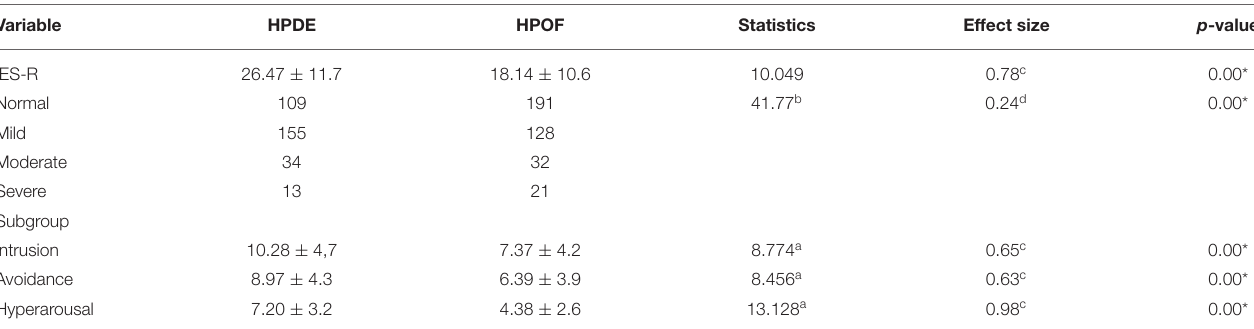
TABLE 2 | Impact Event